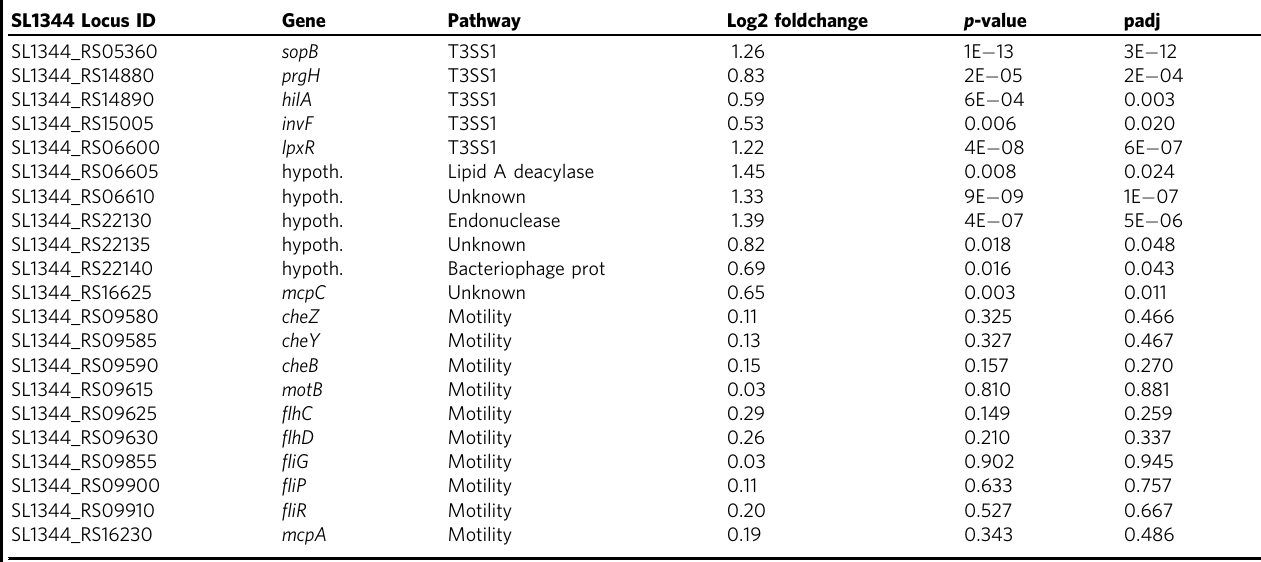
Table 1 RNA sequencing results comparing WT and hilD Δ 3 ′ UTR. SL1344 Locus ID